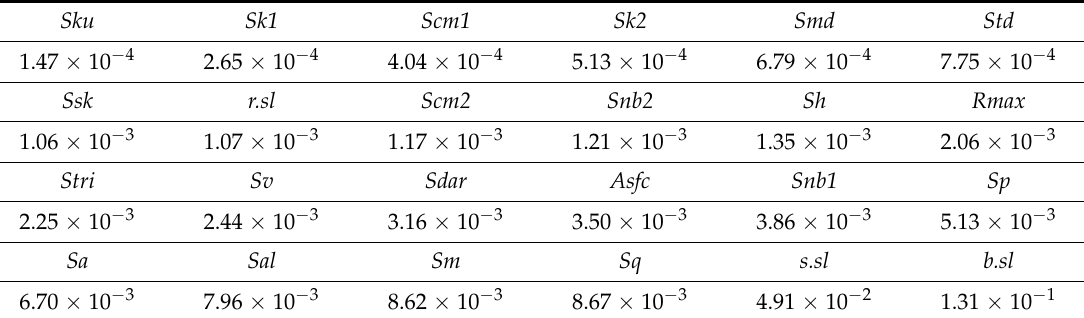
Table 4. Mean p -value of the parameters for all group